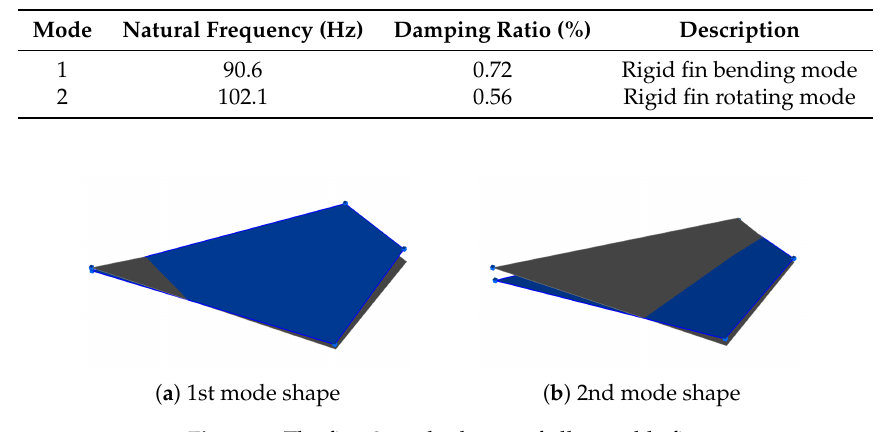
Figure 4. The experimental set-up of ground vibration tests. Table 1. Natural frequencies and damping ratios of the first 2 modes of all movable fin up to 150 Hz.